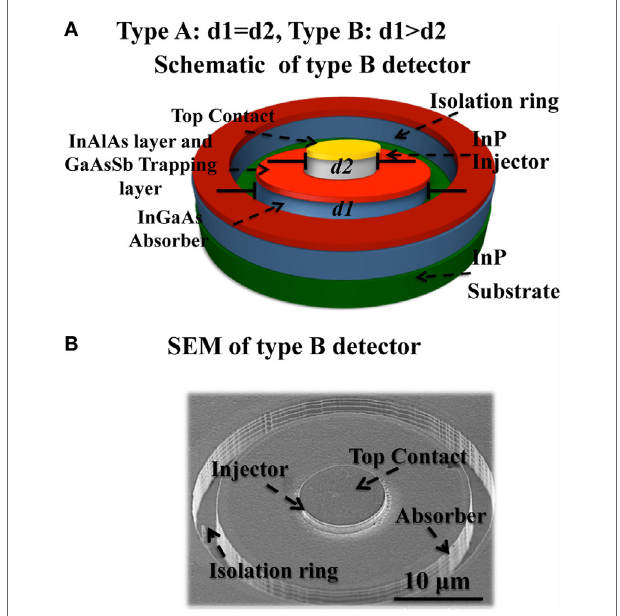
FiGURe 14 | (A) Schematic diagram and (B) SEM of type B electron- injection detector with 10 μ m injector diameter and 30 μ m absorber diameter. d1 and d2 refer to the trapping/absorbing layer and injector diameters respectively. Reproduced with permission from Fathipour et al. (2015). Copyright 2015 AIP Publishing